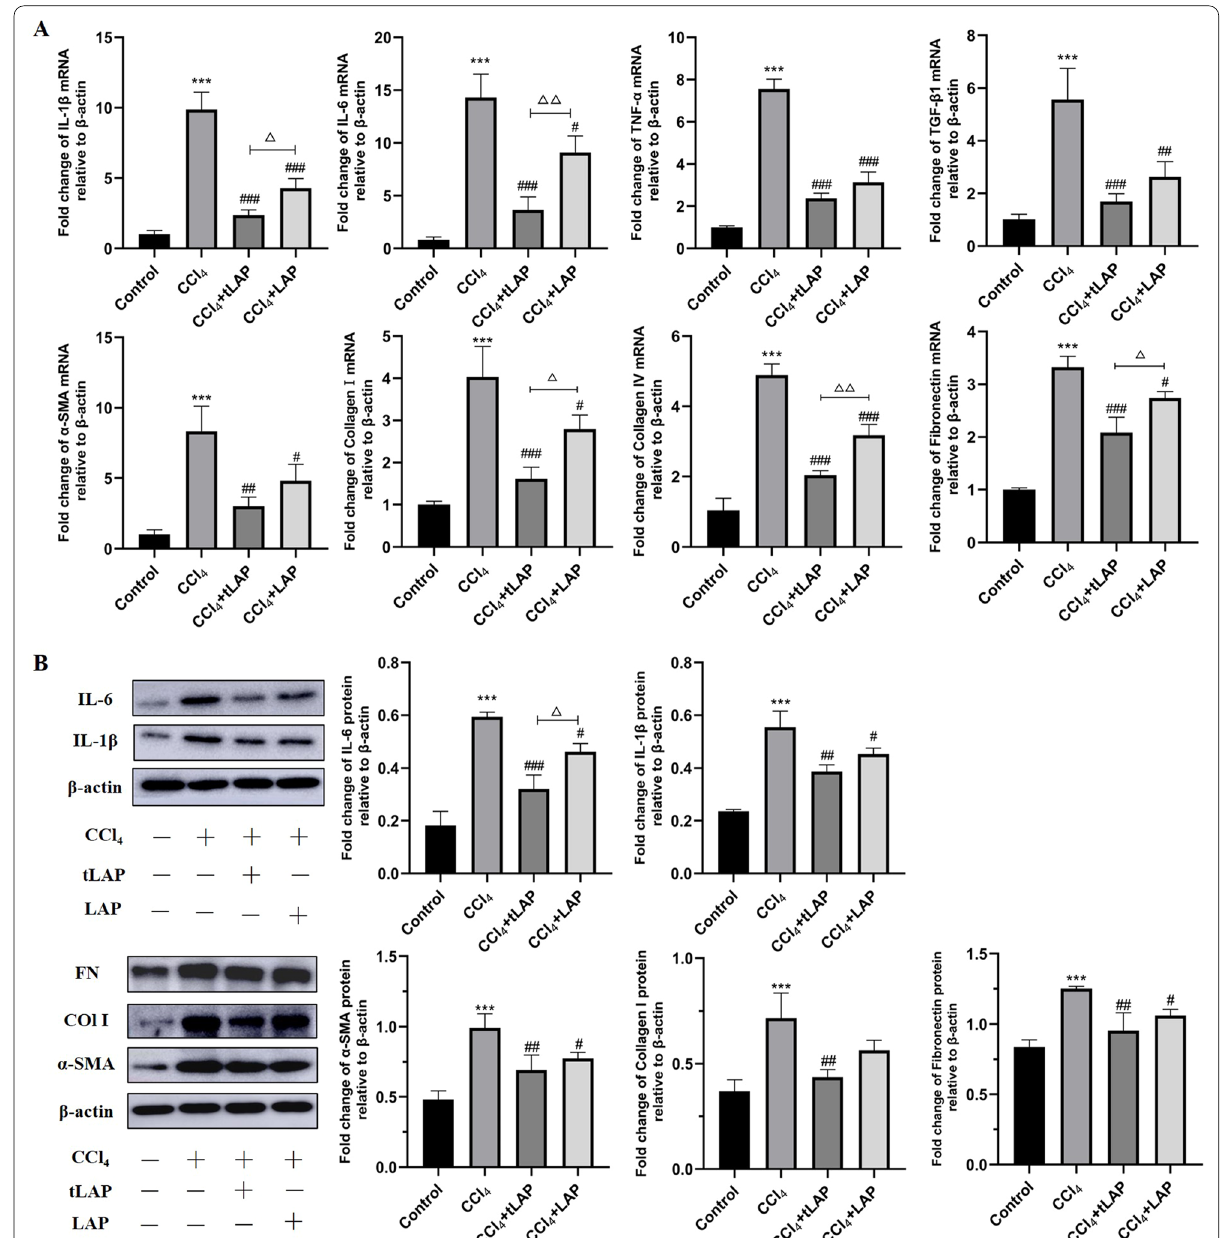
Fig. 6 Detection of the effect of LAP and tLAP on fibrosis-related protein and mRNA expression in C57BL/6 mice. A Detection of the mRNA expression of IL-1β, IL-6, TNF-α, TGF-β, α-SMA, Collagen I, Collagen IV, and Fibronectin in C57BL/6 mice. B Detection of the expression of IL-1β, IL-6, α-SMA, collagen I and Fibronectin in C57BL/6 mice. ***P < 0.001 vs control group; # P < 0.05 vs CCl 4 group; ## P < 0.01 vs CCl 4 group. ### P < 0.001 vs CCl 4 group; △ P < 0.05,